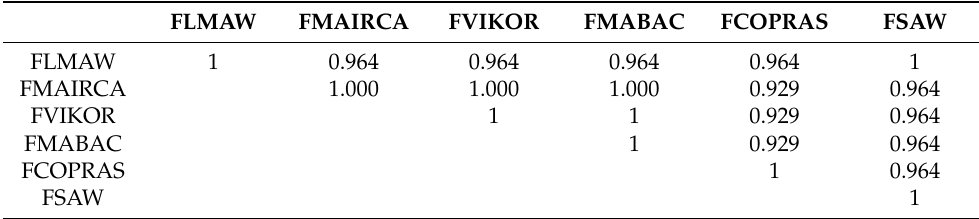
Figure 3. Rank of alternatives by applying different multi-criteria decision-making methods. The SCC values are given in Table 11. Table 11. SCC values for alternative ranks obtained by different MCDM methods.